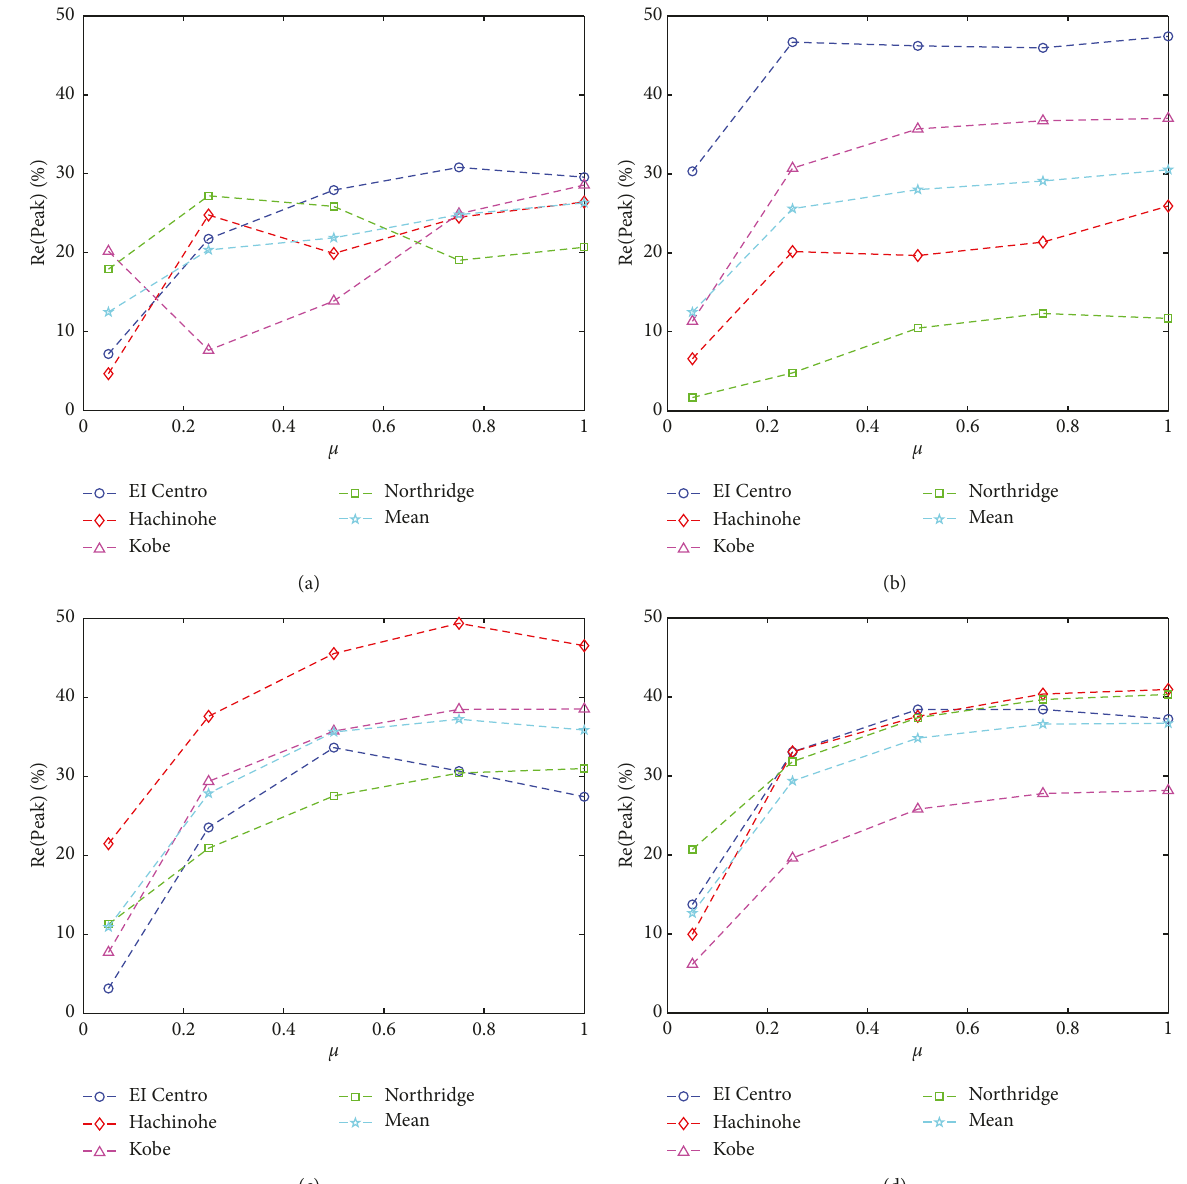
Figure 12: The damping effect of different mass ratio (TMD) on the peak value of structural displacement response. (a) T T 1.0s. (c) T 2.0s. (d) T (cid:31) (cid:31) (cid:31)